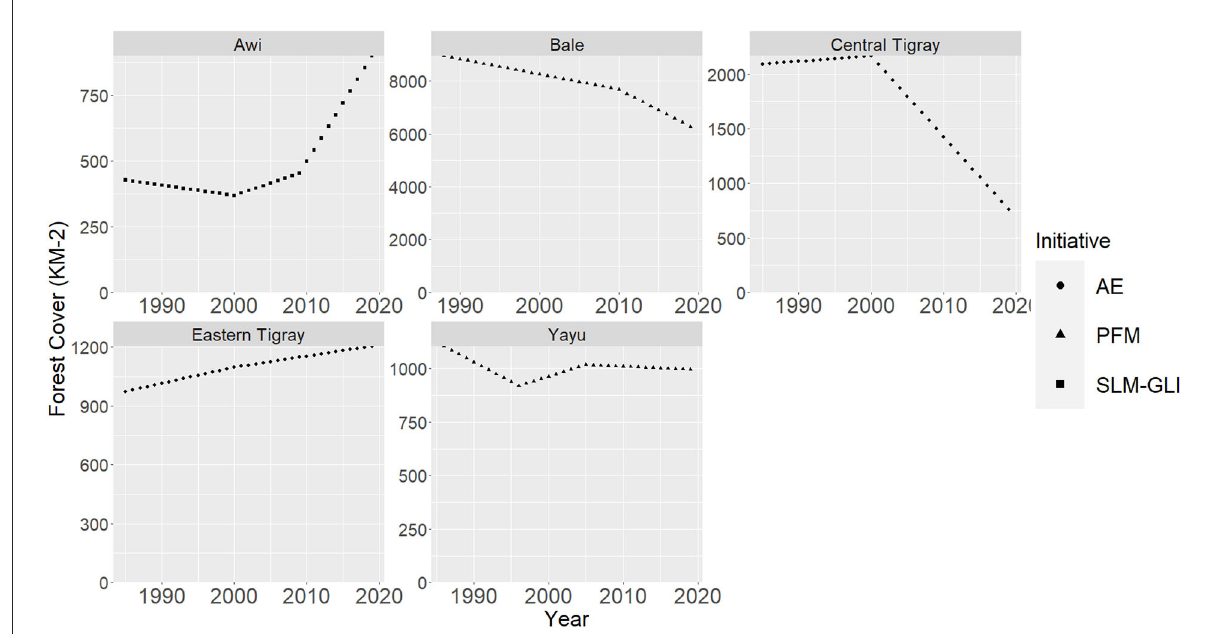
FIGURE3 Forest cover change between 1980 and 2020 in selected areas where the different FLR initiatives have been